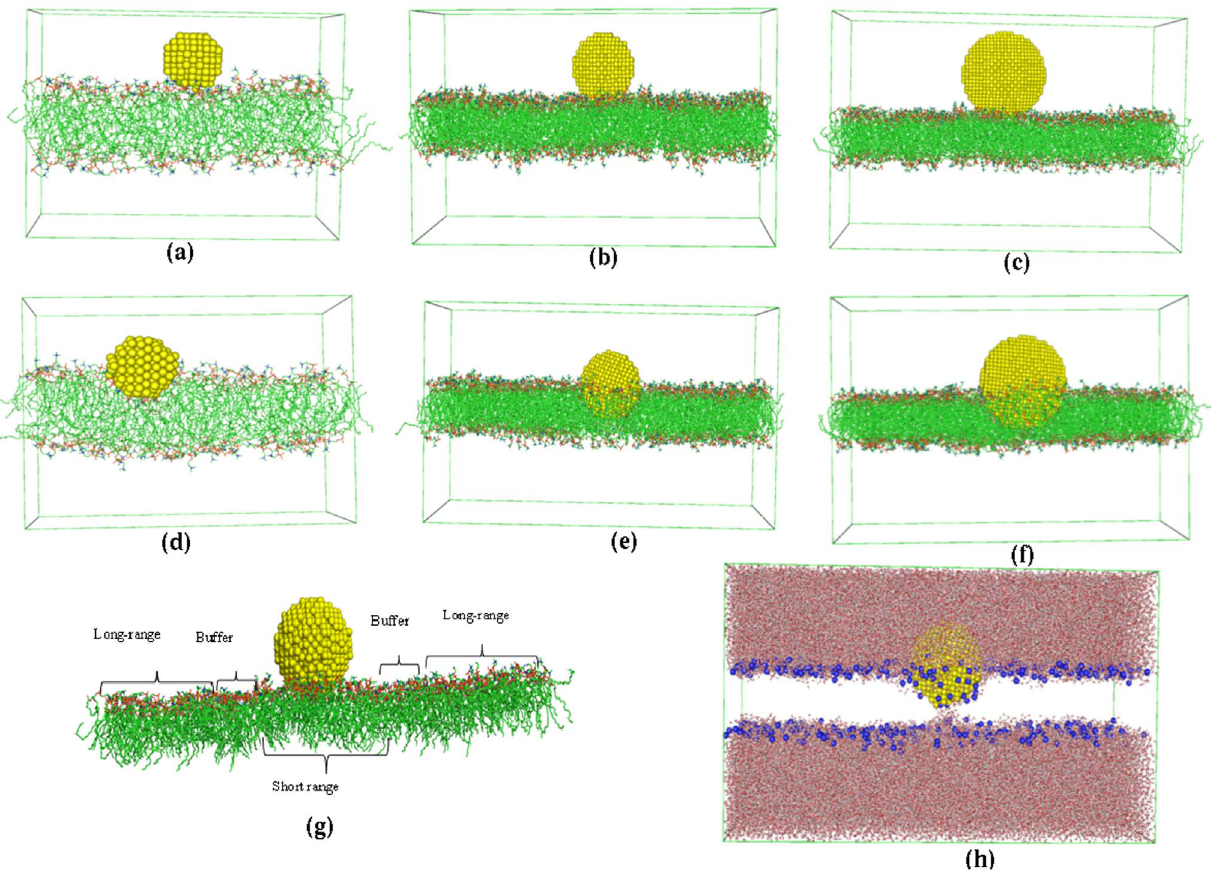
Figure 1. Initial and final snapshots after 100 ns MD simulation of three systems. (a, d) 2 nm_AuNP (b, e) 3.5 nm_AuNP and (c, f) 5 nm_AuNP. (g) Schematic representation of the short range (SR), long range (LR) and buffer region. (h) snapshot of 3.5 nm_AuNP system with explicitly represented head- group Nitrogen atoms in blue color.